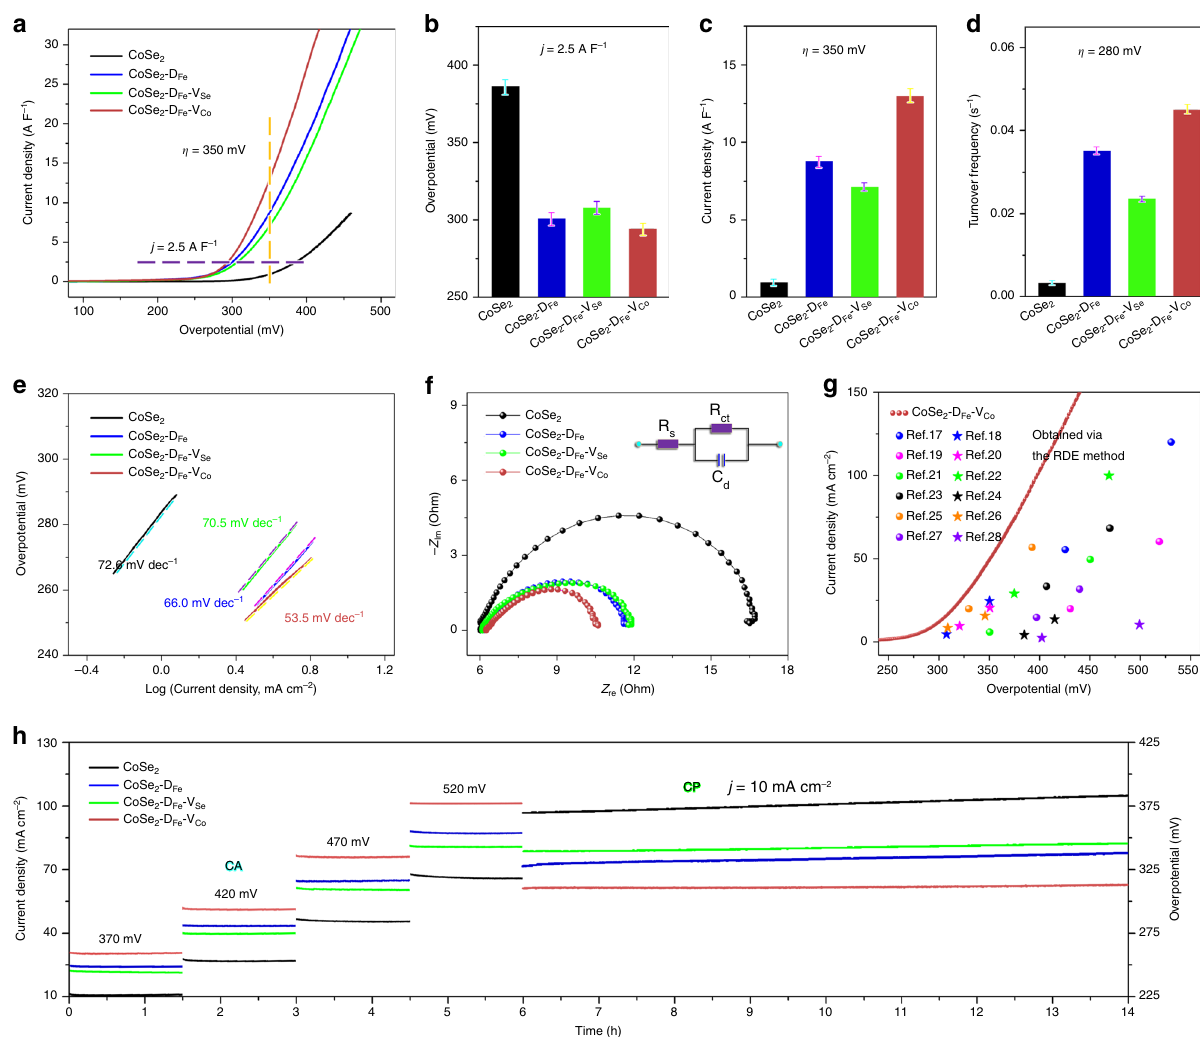
Fig. 2 Catalytic performance for the oxygen evolution reaction. a Linear sweep voltammetry curves normalized by electrochemical double-layer capacitance. b Overpotentials ( η ) required to reach a current density ( j ) of 2.5 A F − 1 . c Current densities at η = 350 mV. d Turnover frequencies calculated at η = 280 mV. e Tafel plots derived from the polarization curves in low overpotential regions. f Nyquist plots at η = 370 mV with inset showing the equivalent circuit model. g Comparison of the catalytic performance between CoSe 2 – D Fe – V Co and previously reported CoSe 2 and FeCo compounds evaluated via the rotating disk electrode (RDE) method. h Durability evaluation via chronoamperometry test at stepwise η of 370, 420, 470, and 520 mV for 6 h, and chronopotentiometry test at j = 10 mA cm − 2 for 8 h. The error bars in b – d denote standard deviation of fi ve technical